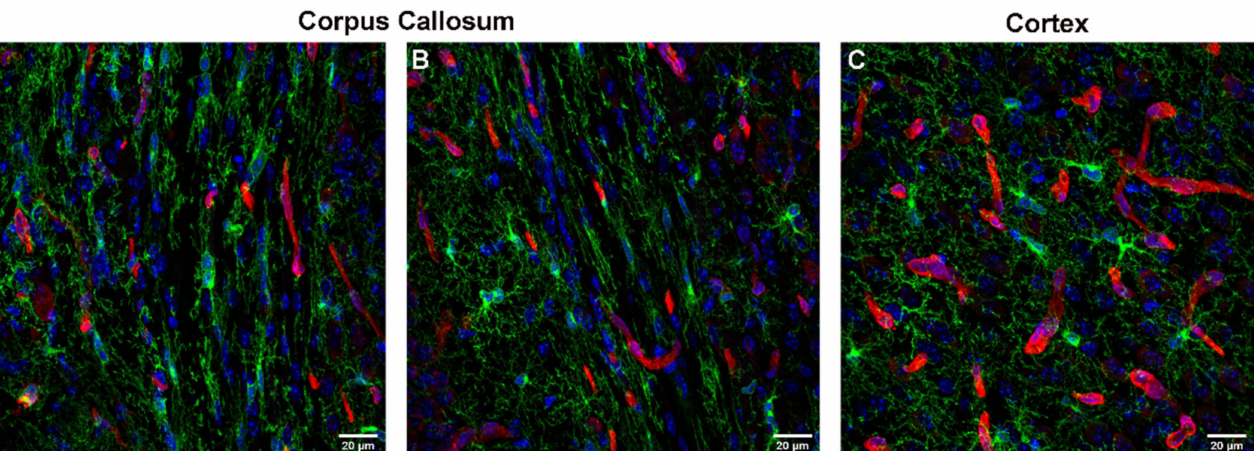
Figure 2. ( A ). Percentage of OPCs per field of view in mouse cortex and corpus callosum compared at P15 and P60. ( B ). Percentage of OPCs that established contact with blood vessels in cortex and corpus callosum at P15 and P60. ( C ). Percentage of blood vessels that were contacted by OPCs in cortex and corpus callosum at P15 and P60.